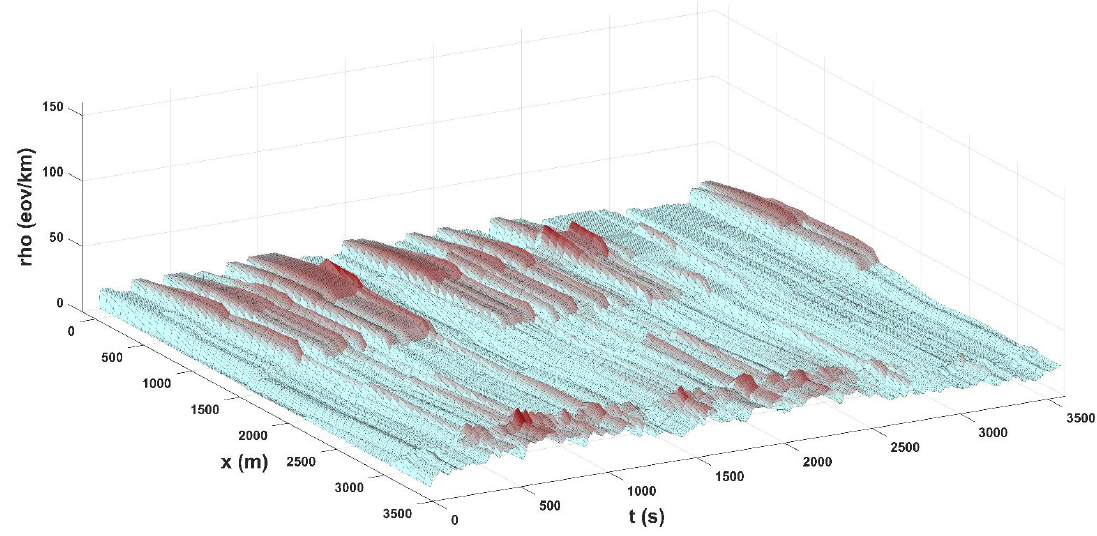
Figure 8. Density in time and space in scenario 1 in VSL controlled case.